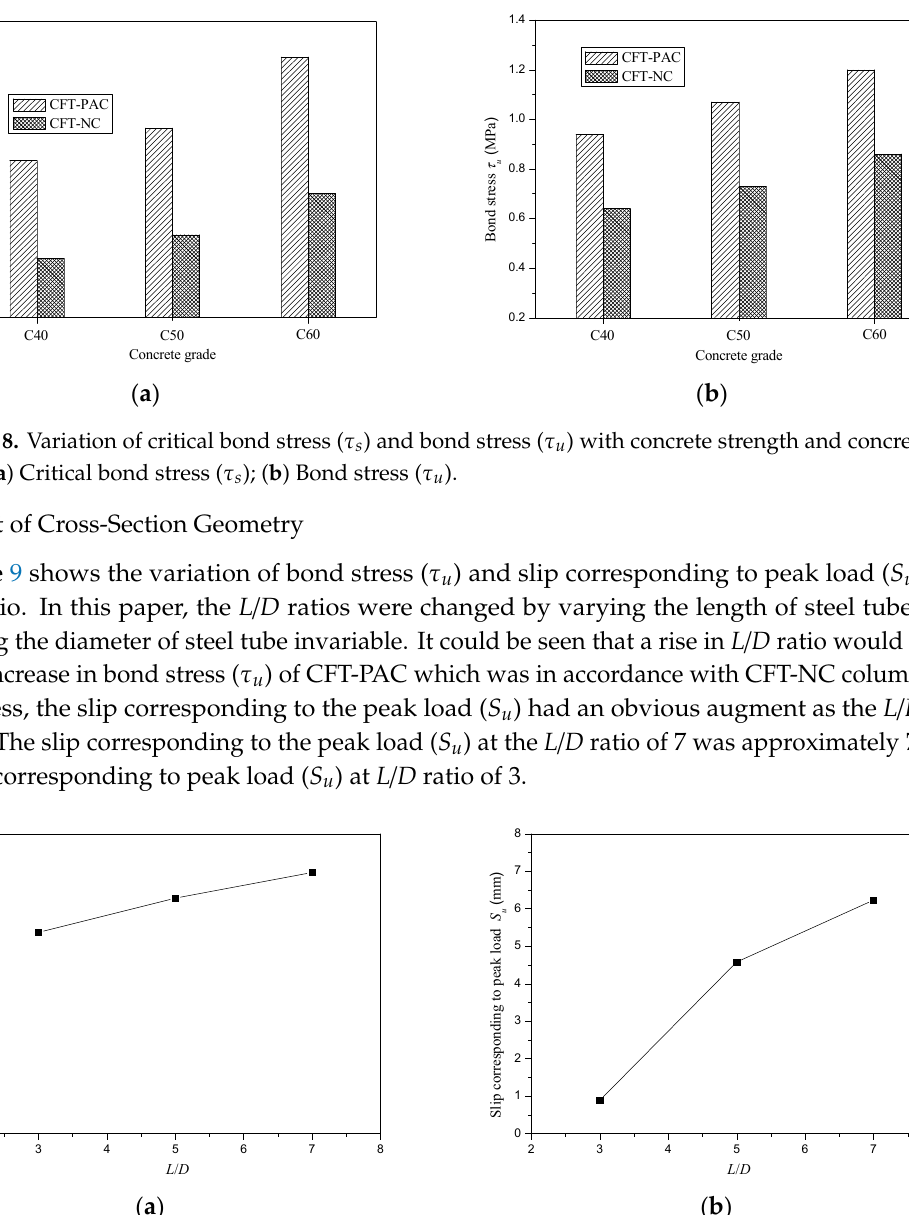
( b ) Figure 10. Variation of bond stress ( τ u ) and slip corresponding to peak load ( S u ) with D/t ratio. ( a ) Bond stress ( τ u ); ( b ) Slip corresponding to peak load ( S u ).